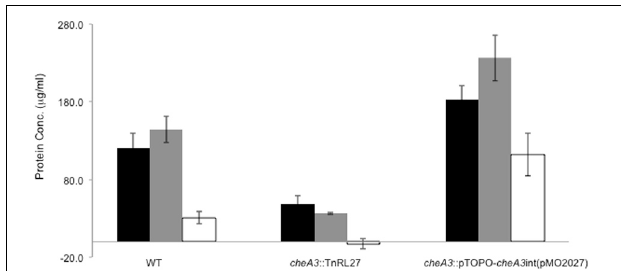
FIGURE 5 | Palleroni chamber assay to examine the accumulation of cells in a capillary tube containing either 30mM sulfate (black bar), 60mM lactate (gray bar), or PBS (white bar) for the wild type, cheA3 mutant cheA3:: TnRL27 and the cheA3 complement cheA3:: pTOPO -cheA3int (pMO2027) strains. Assays were conducted in triplicate. Error bars are standard deviation of the means.